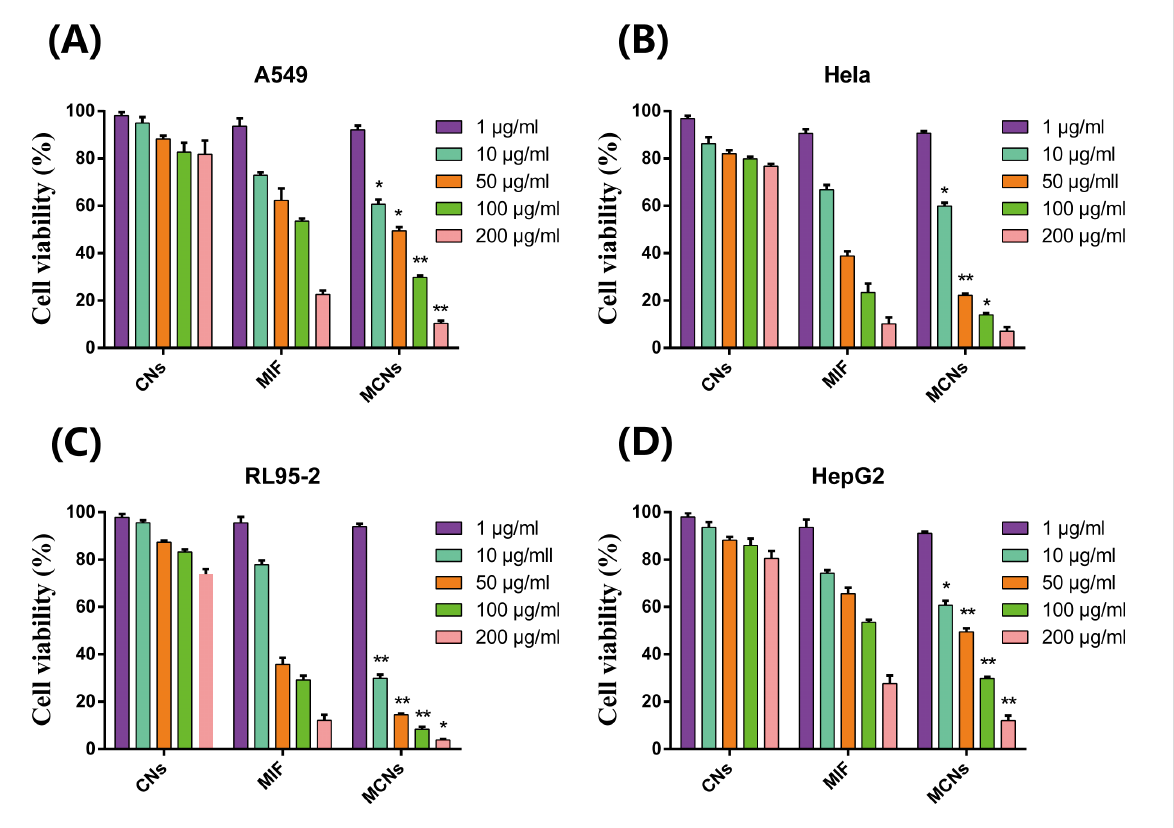
Figure 7: In vitro cytotoxicity of CNs, MIF and MCNs against A549 (A), Hela (B), RL95-2 (C), and HepG2 cells (D). Cells were incubated with differ- ent concentrations (1, 10, 50, 100, 200 μ g/mL) of blank CNs, free MIF, or MCNs for 48 h at 37 °C before subjecting them to MTT assay. * p < 0.05 and ** p < 0.01 compared with the MIF group by the Student’s t -test.